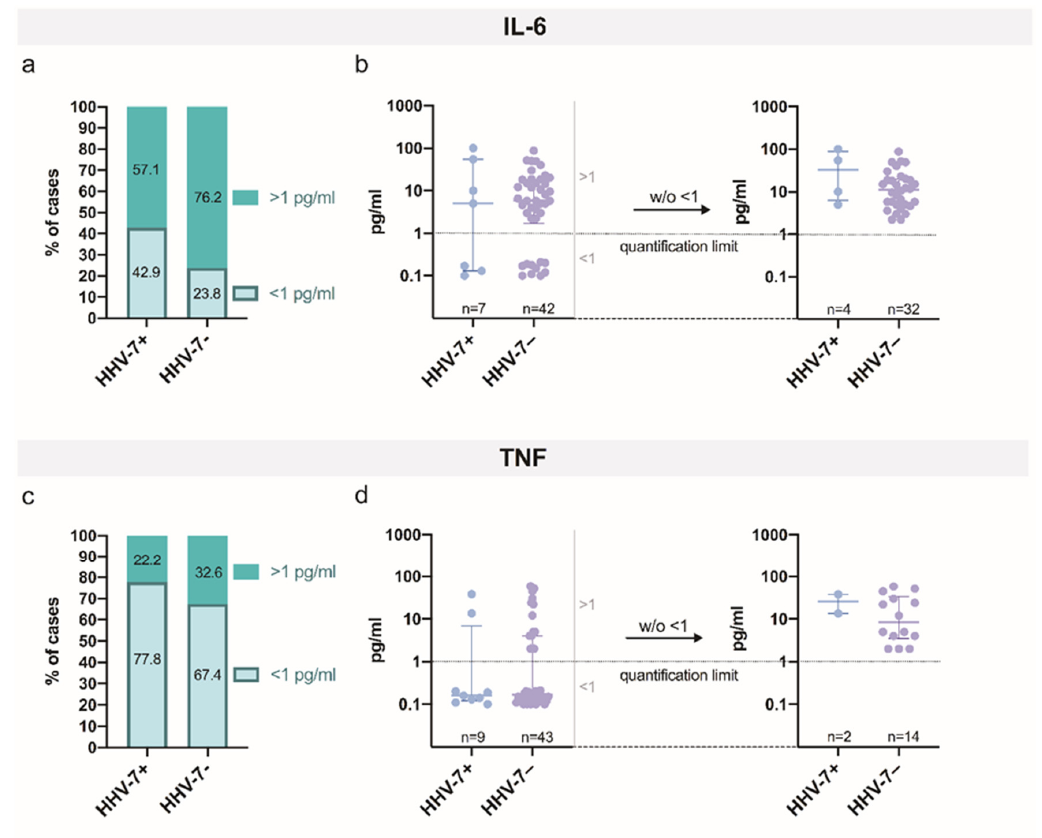
Figure 2. Assessment of plasma levels of pro-inflammatory cytokines—tumor necrosis factor (TNF) and interleukin-6 (IL-6)—in osteoarthritis (OA) patients in both study groups, HHV-7 PCR+ and HHV-7 PCR − . Plots depict the distributions of IL-6 ( a ) and TNF ( c ) plasma levels demonstrated in OA patients in both study groups—HHV-7 PCR+ and HHV-7 PCR − . ( b , d ) Dot plots represent the quantified data for IL-6 ( b ) and TNF ( d ) plasma levels. ( b ) Each dot represents a single data point; blue dots represent IL-6 plasma levels assessed in the HHV-7 PCR+ group, and violet dots represent IL-6 plasma levels assessed in the HHV-7 PCR − group. ( d ) Each dot represents a single data point; blue dots represent TNF plasma levels assessed in the HHV-7 PCR+ group, and violet dots represent TNF plasma levels assessed in the HHV-7 PCR − group. The quantification limit (QL) for the assay of cytokine assessment was set as 1 pg/mL. Cytokine levels below QL (<1) were uniformly set as random values around QL/10. The right part of graph ( b ) and graph ( d ) represent data excluding values below the detection (quantification) level (w/o < 1), i.e., data without values of less than 1 (w/o < 1). W/o— without (write-off).